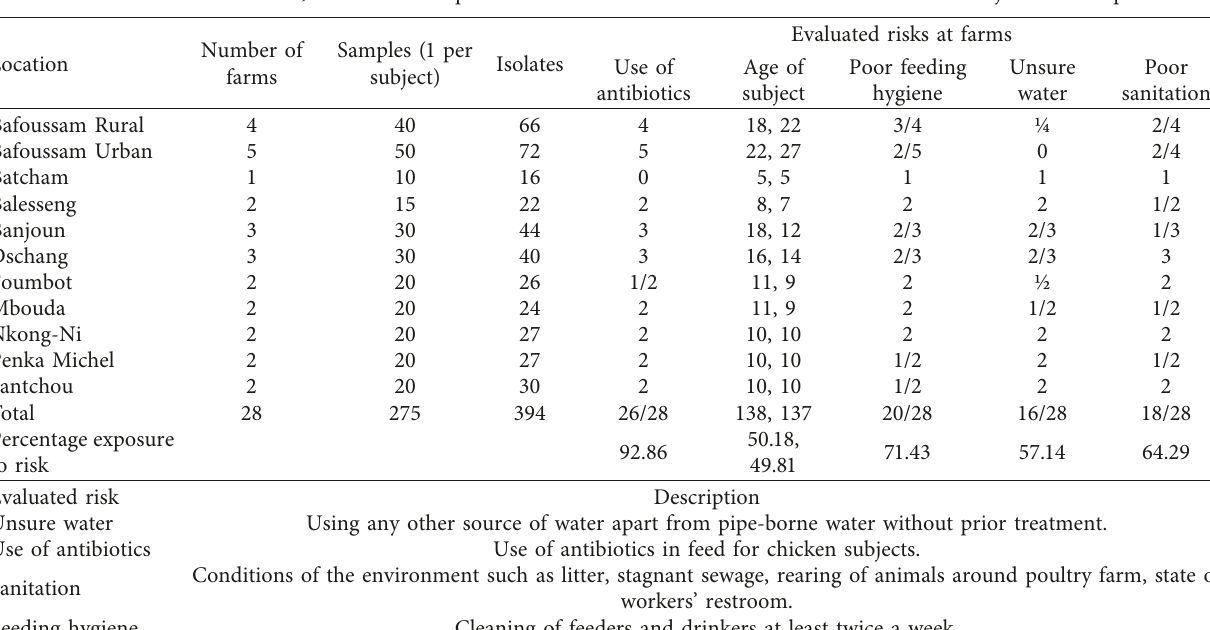
Table 4: Locations of farms, number of samples and isolates and the risk factors to which chicken subjects were exposed. Location